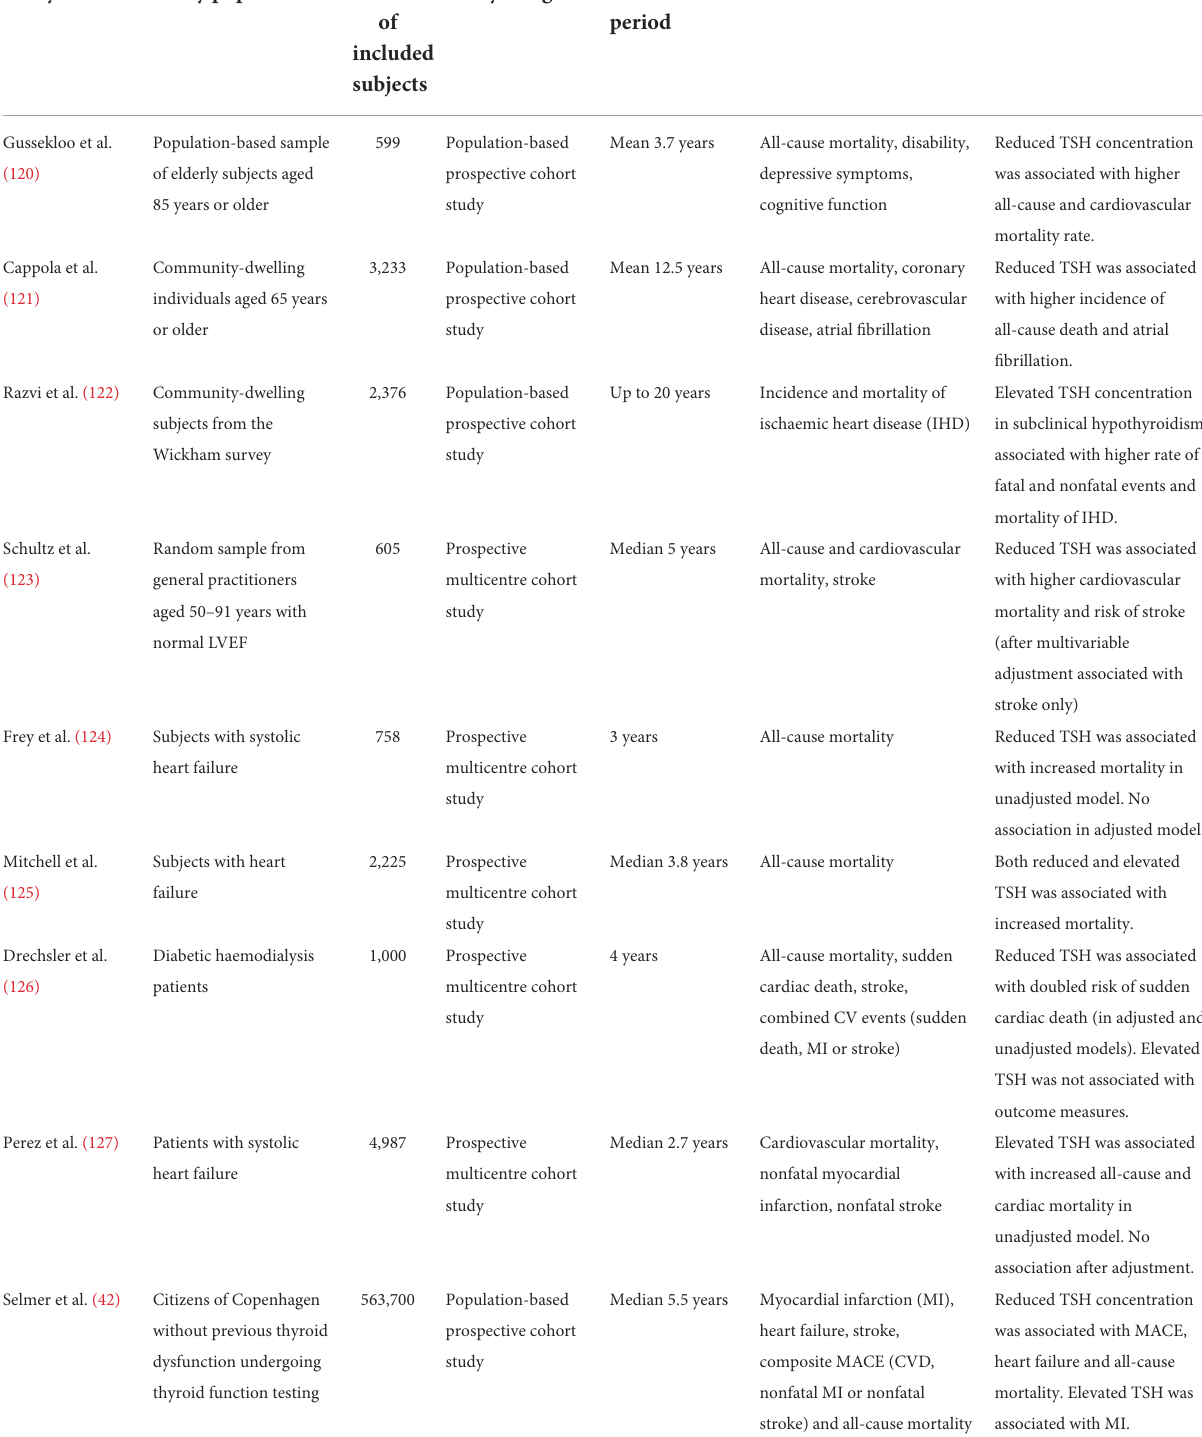
TABLE 2 Association between TSH concentration and major cardiovascular outcome measures.